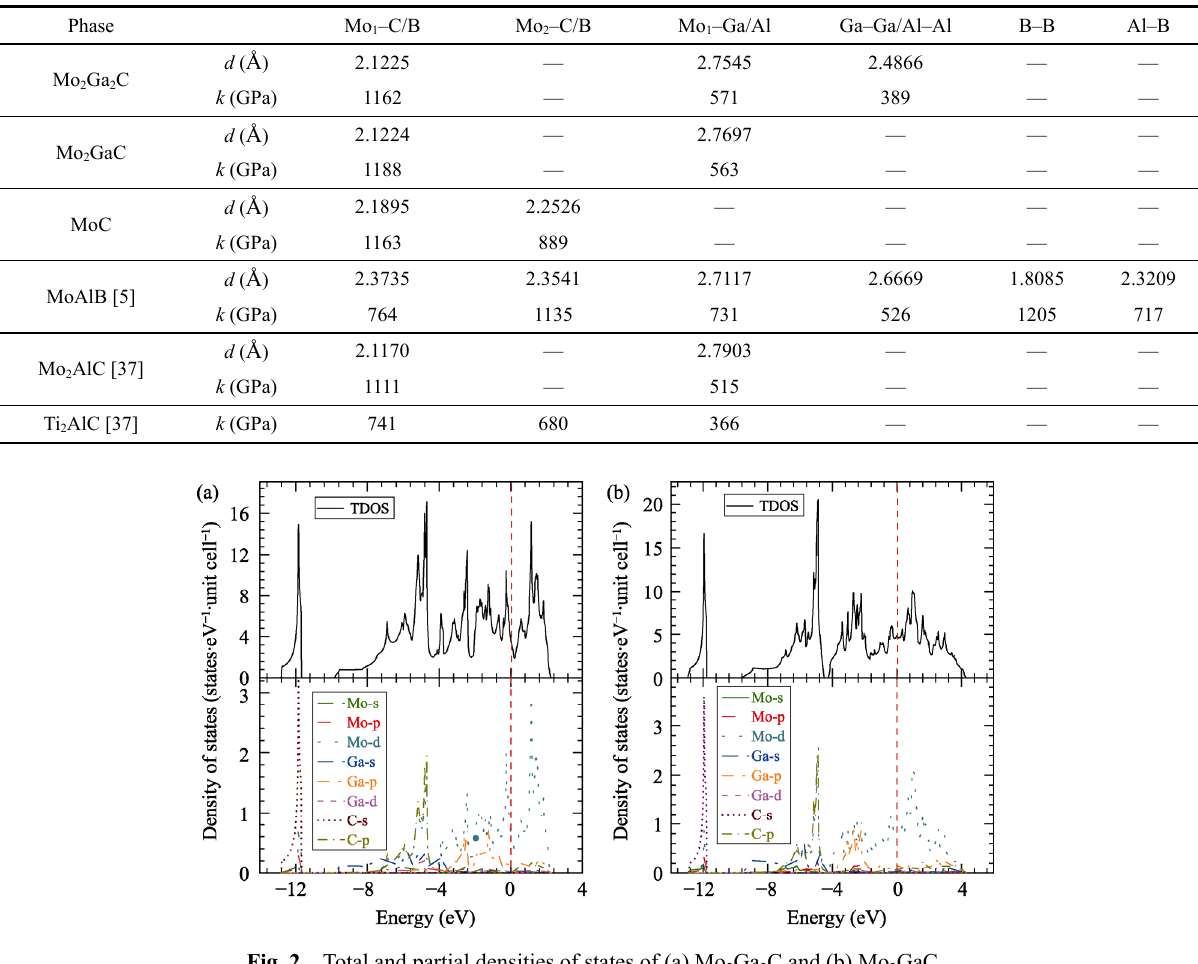
Table 2 Bond length ( d ) and bond stiffness ( k ) in Mo 2 Ga 2 C, Mo 2 GaC, MoC, and typical MAX phases